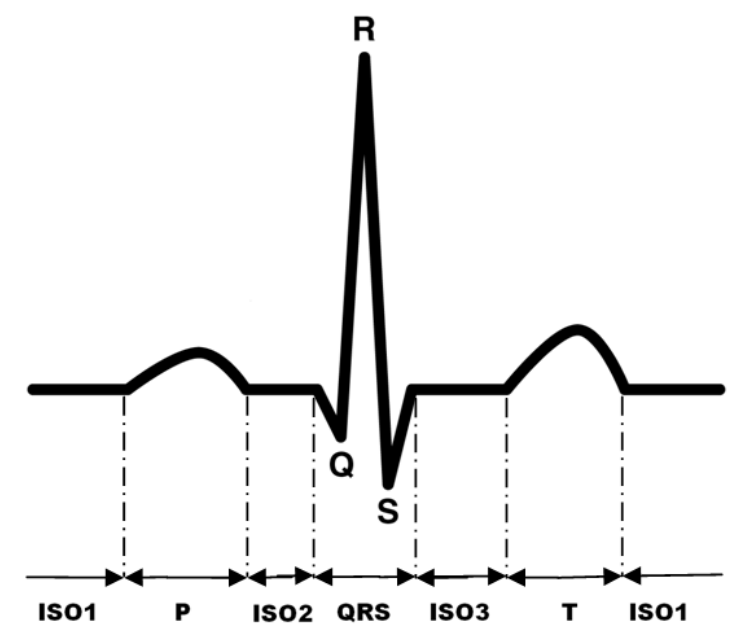
Figure 11. ECG waveform and its subwaves (P subwave, QRS complex, T subwave and isoelectrics) in a cardiac